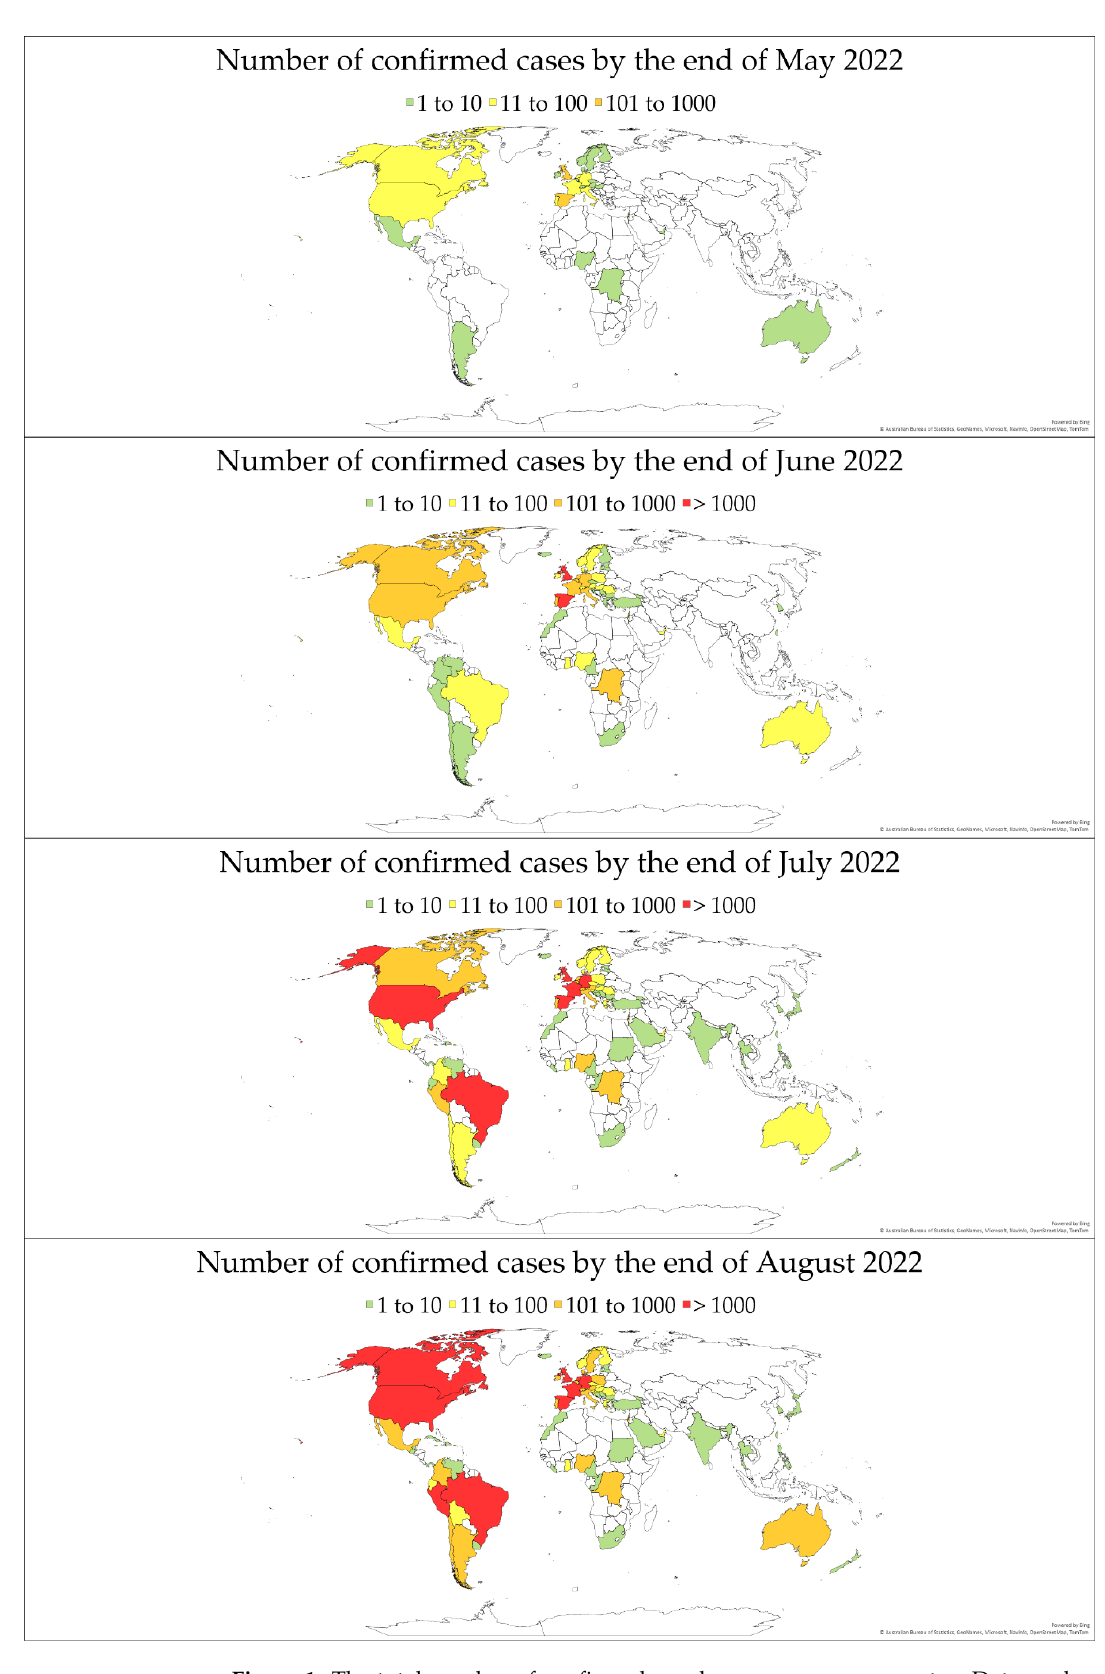
Figure 1. The total number of confirmed monkeypox cases per country. Data are based on (Our- WorldInData.org, accessed on 9 September 2022) as reported by the end of May, June, July, and August 2022 [18].